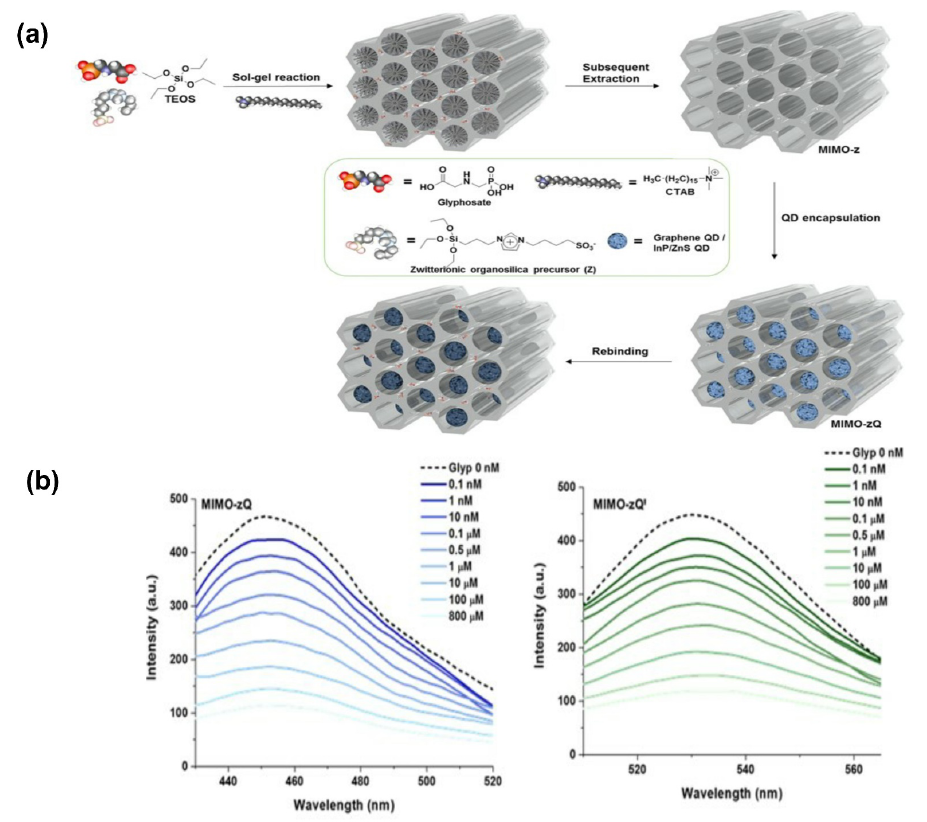
Figure 27. ( a ) Schematic illustration of the synthesis of QD-encapsulated GLYP imprinted mesoporous organosilica (MIMO-zQ), ( b ) Photoluminescence decrease as a function of the GLYP concentration for both MIMO-zQ preparations, graphene QDs (left) and InP/ZnS QD (right). Reprinted with permission from [209]. Copyright 2019 Nature. A three-dimensional microfluidic paper-based analytical device (3D-µPAD) using Mn–ZnS quantum dots embedded in a molecularly imprinted polymer (Mn-ZnS QD-MIP)